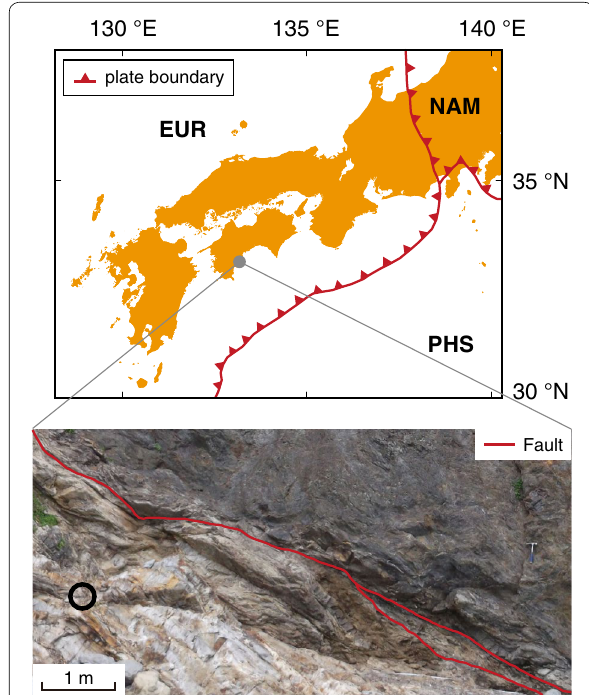
Fig. 1 Example of a CM-bearing fault. Location (upper) and photo- graph (lower) of an ancient plate-subduction fault developed in the Kure Mélange, Shikoku, Japan. The sampling point of CM-bearing non-deformed shale is shown by the black circle on the photograph of the outcrop. EUR Eurasia plate, NAM North American plate, PHS Philippine Sea